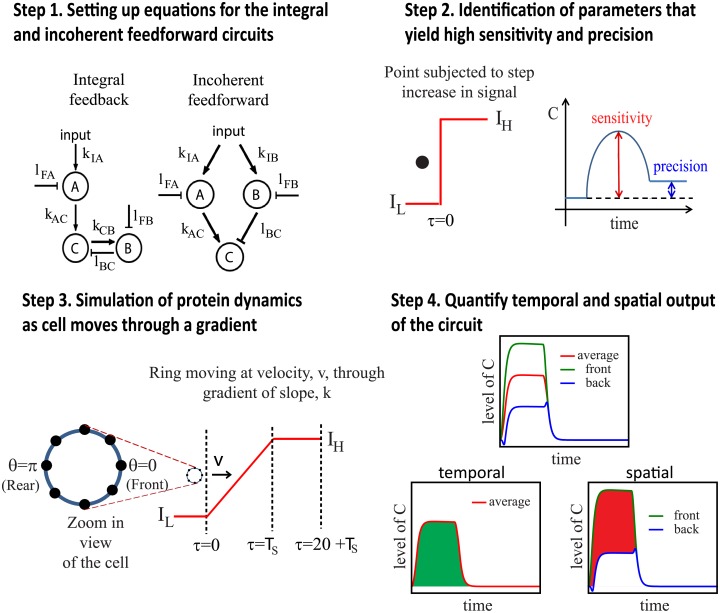
Steps in the computational modelling of network motifs.